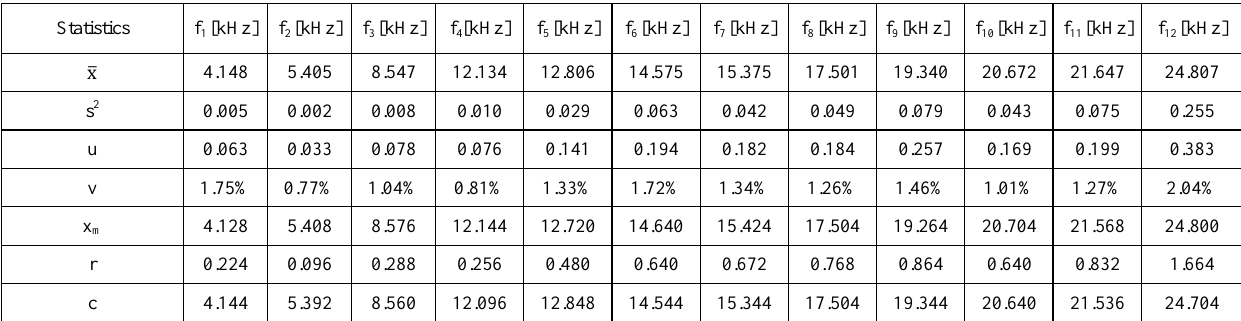
Table 2. Statistical measures for the frequencies of 12